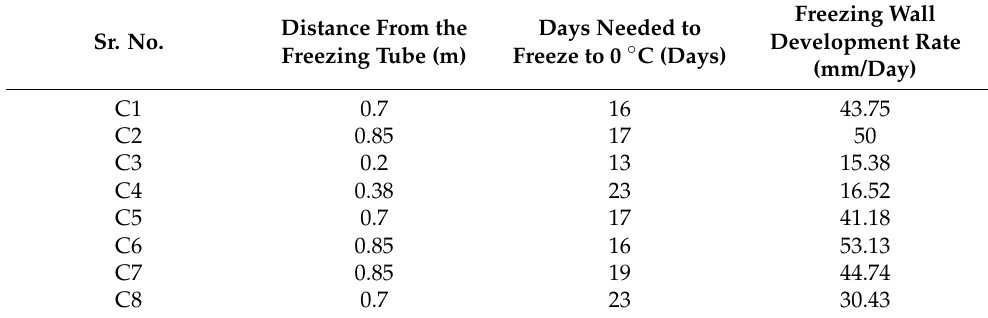
Table 3. Slowest freeze wall development rate summary at the measured point. Sr. No.